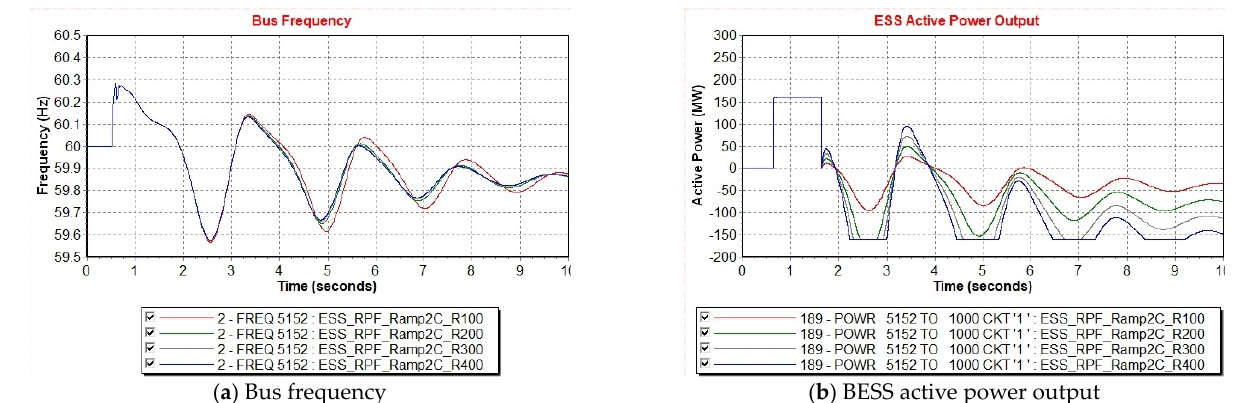
Figure 11. Performance of a hybrid control BESS with different frequency response droop gain.